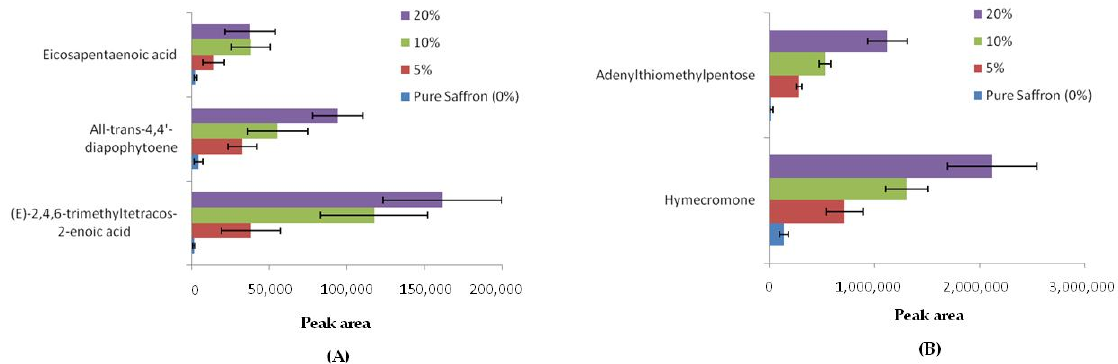
Figure 5. Signal intensity variation of candidate marker compounds among the inclusion levels of adulteration explored: 0 (pure saffron), 5, 10 and 20%: ( A ) safflower markers, ( B ) turmeric markers.